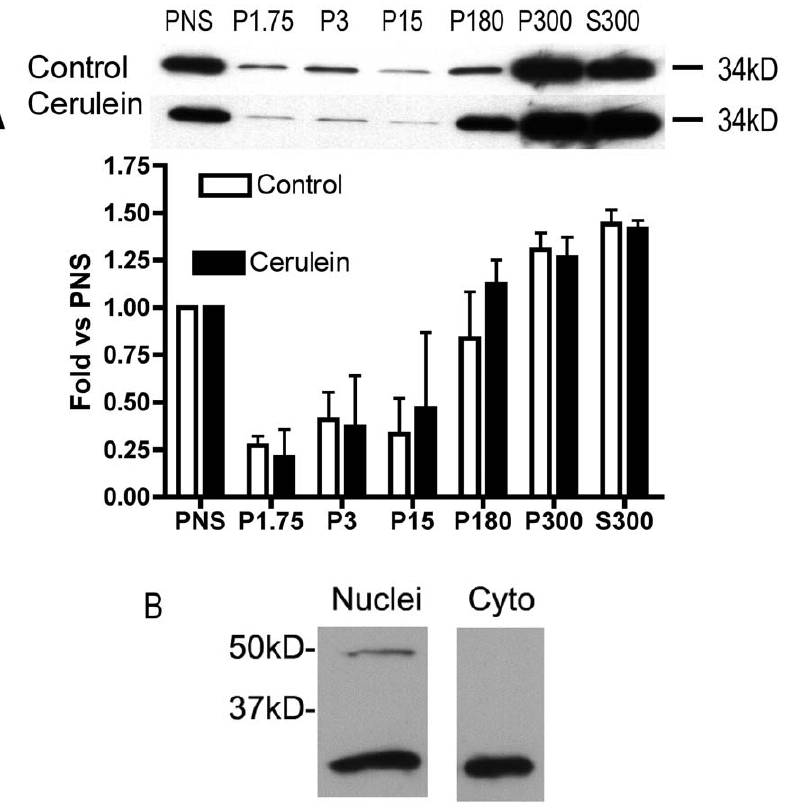
Figure 3. sAC is associated with specific subcellular fractions. (A) Tissue was removed from control and CER treated rats and separated by differential centrifugation into various membrane fractions or cytosol followed by Immunoblot analysis of the 34 kD band of sAC. The top panel shows representative immunoblots and below is quantitation of all experiments (n=3). (B) Immunoblot for sAC using Ab (R21) in cytoplasmic and nuclear protein extract from pancreatic acini (n .